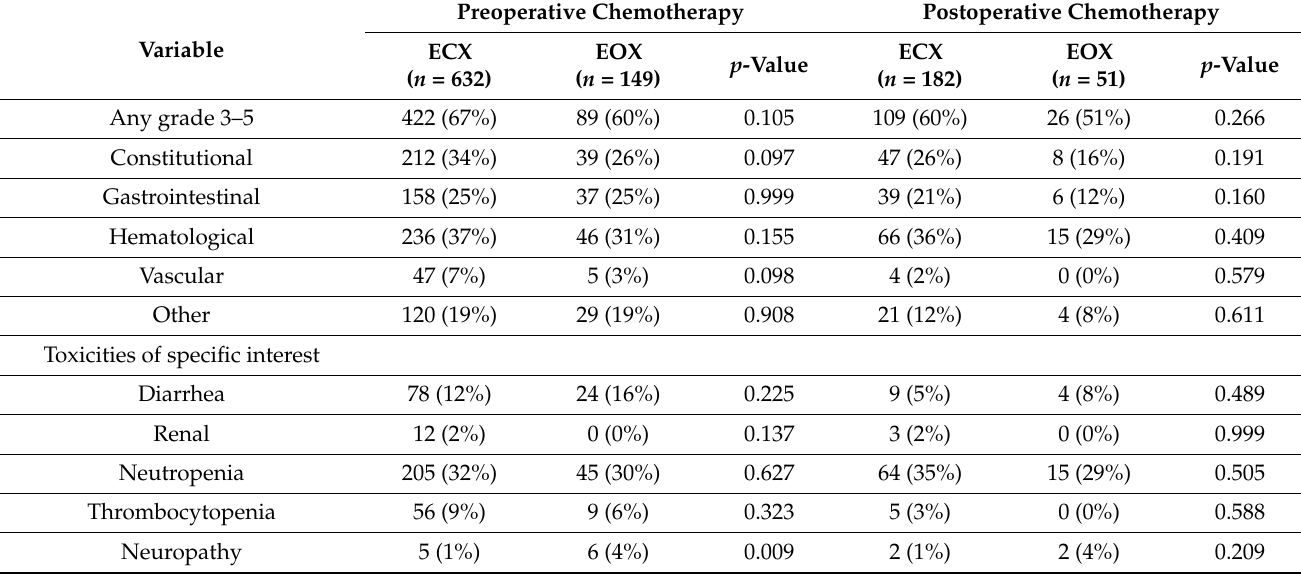
Table 3. Pre- and postoperative grade 3–5